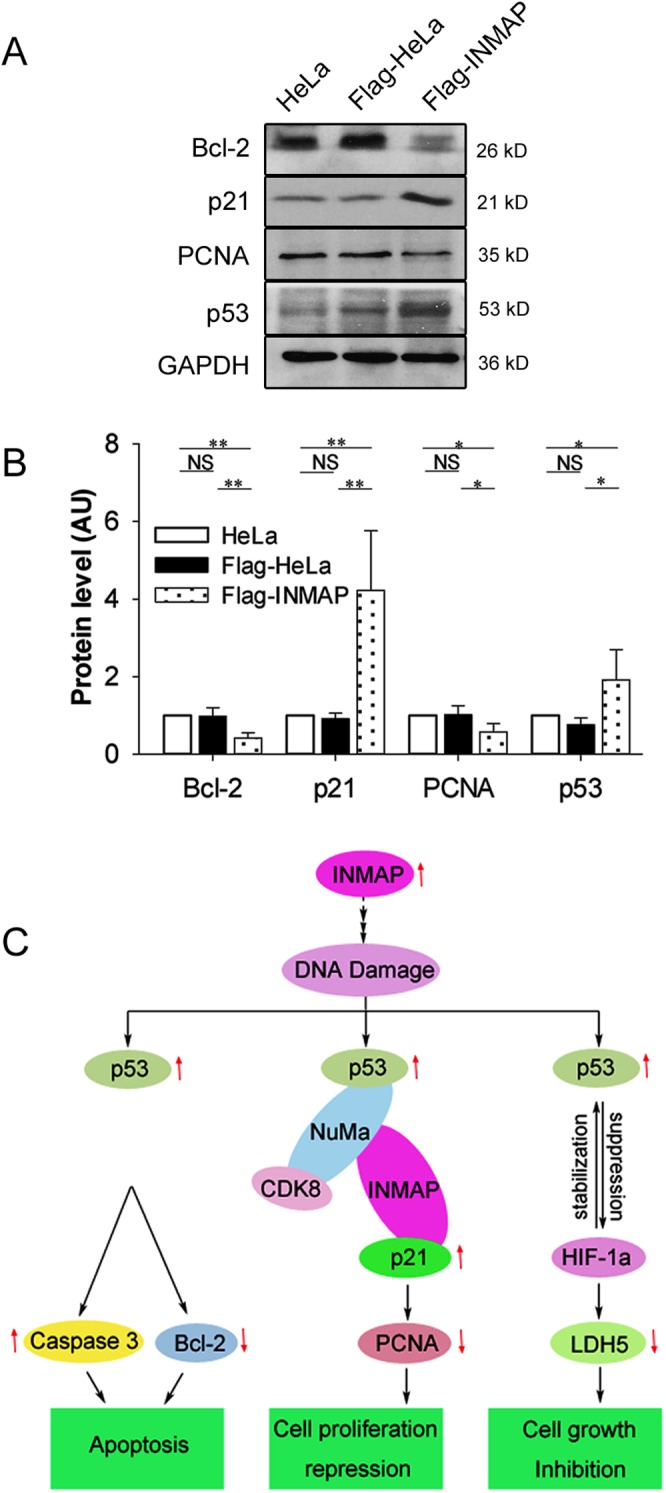
Effects of INMAP overexpression on the expression of genes related to proliferation and apoptosis.(A). Western blot analysis of the three groups of cells (HeLa, Flag-HeLa, and Flag-INMAP) with anti-Bcl-2, anti-p53, anti-p21 and anti-PCNA antibodies. Data shown are representative of three independent experiments. (B). Band quantification was analysed with Image J software. (C). A schematic model illustrating the proposed mechanisms of INMAP-overexpression-induced DNA damage and apoptosis through p53-dependent pathways in transformed cells.